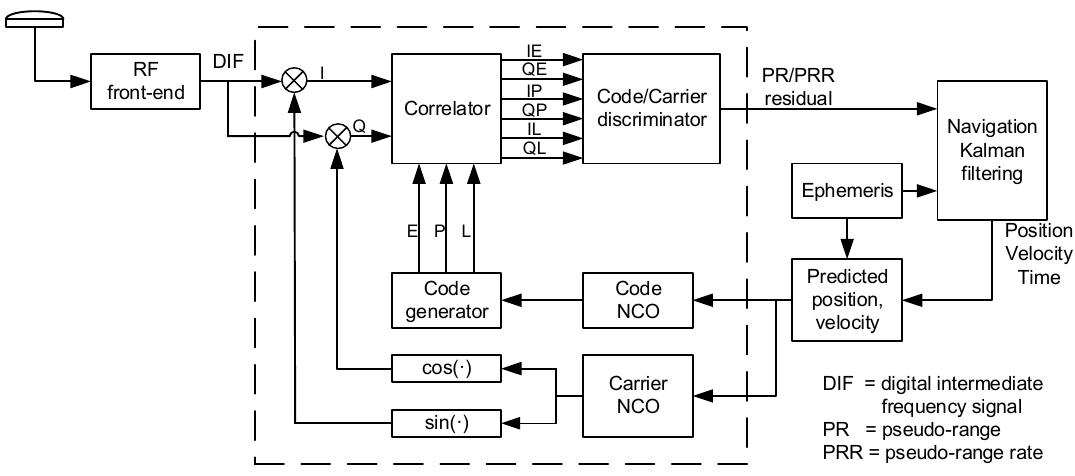
Figure 1. Basic structure of the vector-tracking loops.